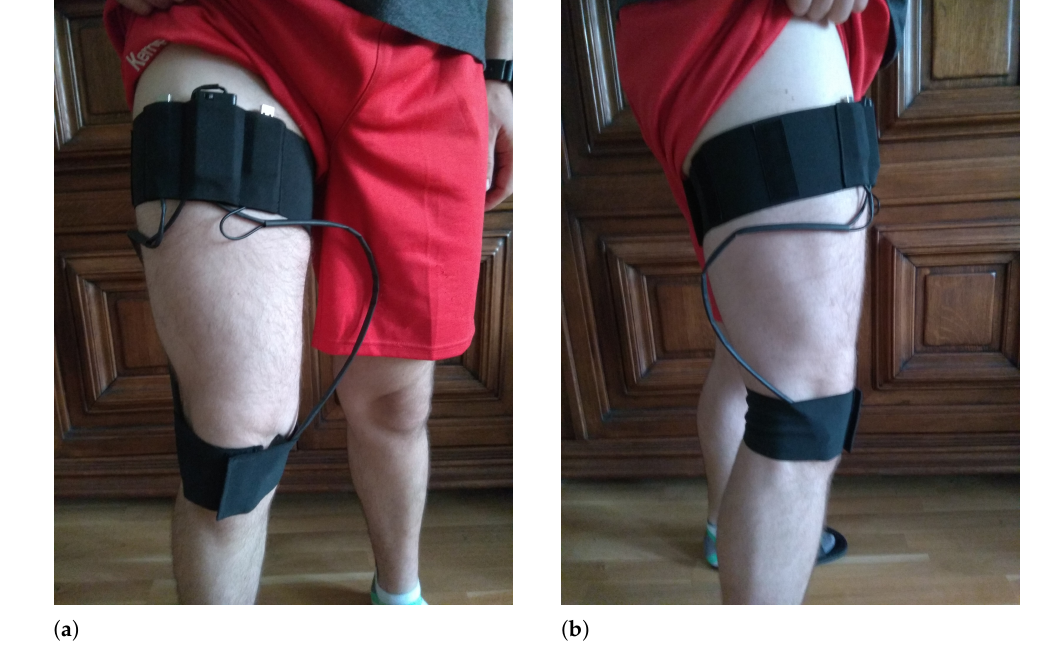
Figure 3. Device placement. ( a ) frontal view; ( b ) sagittal view.